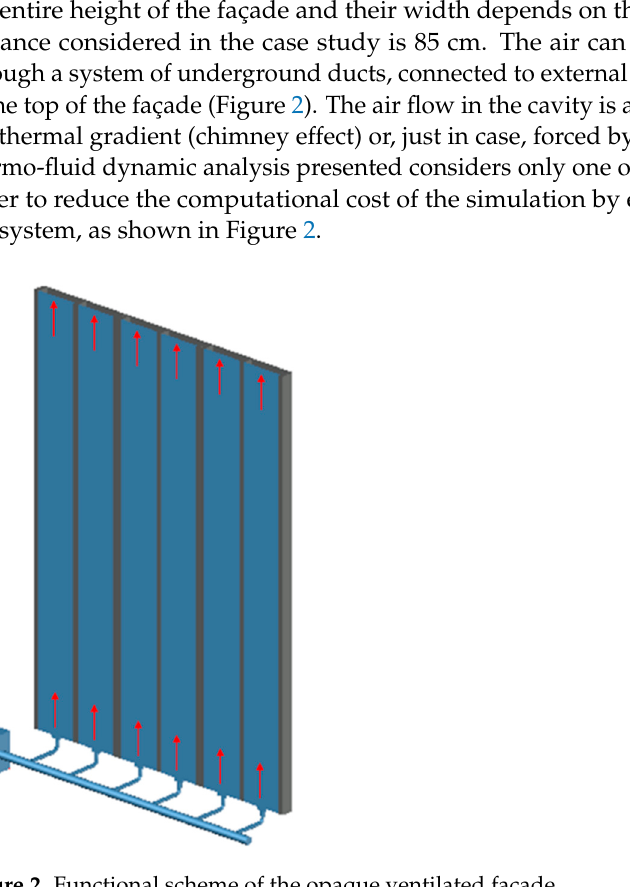
Figure 2. Functional scheme of the opaque ventilated façade.